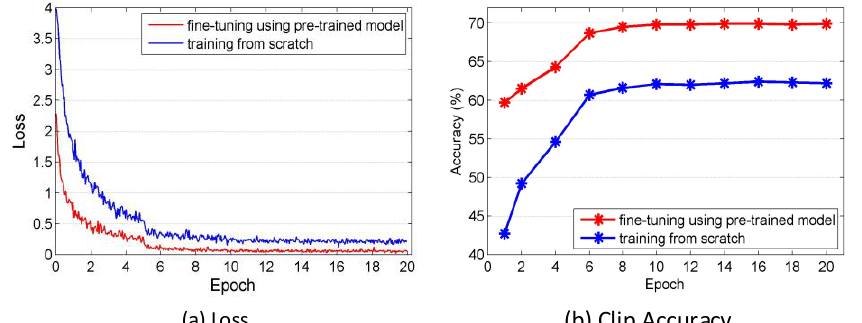
Figure 4. Comparison of two types of training: ( a ) fine-tuning using the pre-trained model; and ( b ) training from scratch. The experiment is conducted in in the optical flow (OF) stream of 8f temporal scale on UCF101 split-1.